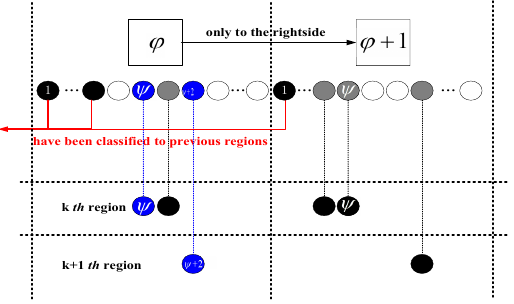
Figure 2. The labelling process in step (IV).